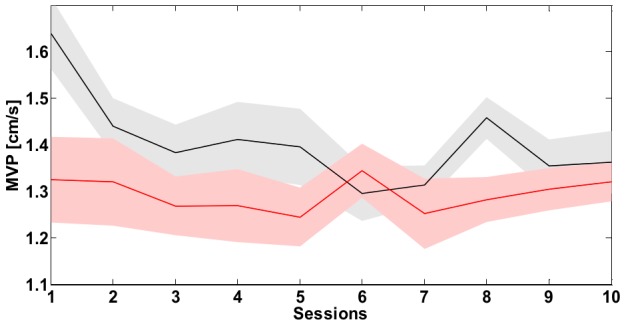
Task A: Magnitude of the Velocity Peaks (MVP).Evolution of the MVP of the virtual mass throughout the ten sessions of training. The continuous line is the mean value over the eight subjects while the shaded area corresponds to the standard error. The black line refers to the SSS while red one to the PSS.